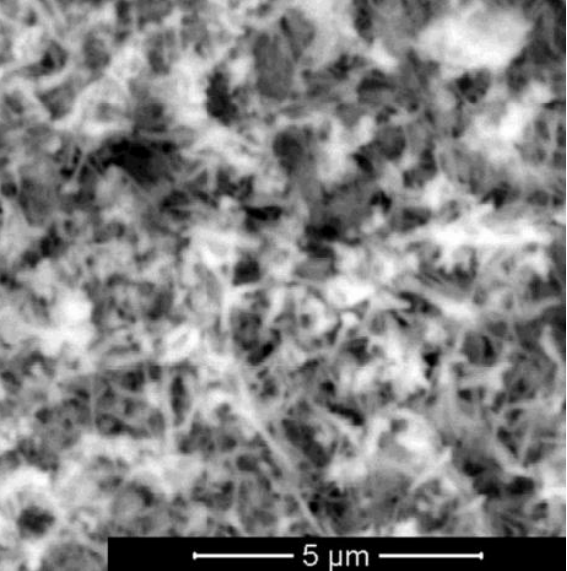
Figure 11. SEM image of ZnO nanowires formed on the surface of Cu-Zn alloy in the process of laser irradiation on the pre-etching material [38].